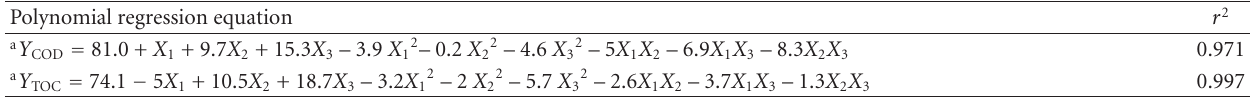
Table 3: Polynomial regression equation of AO10 degradation on the basis of COD and TOC removal. Polynomial regression equation r